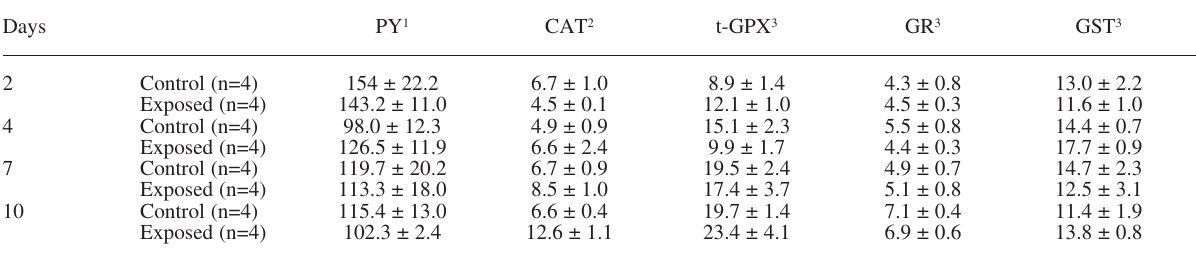
T ABLE 2. – Protein yield (PY), antioxidant enzymes (CAT, t-GPX and GR) and phase II (GST) activity analysed in the cytosolic fraction of the digestive gland of Mytilus